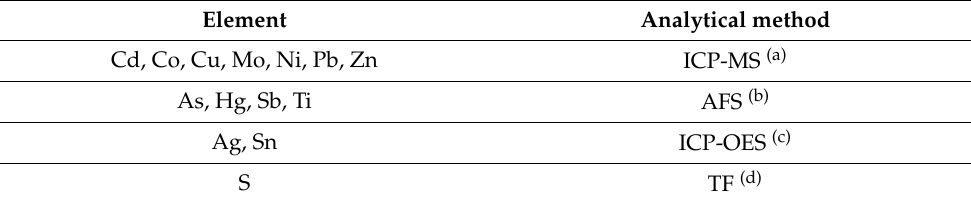
Table 1. List of analytical equipment used to measure the concentrations of the 14 elements.